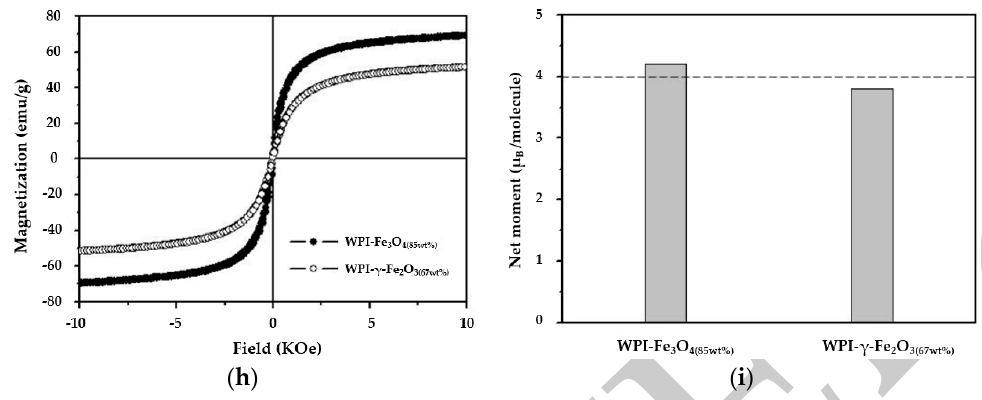
Figure 5. ( a ) Induction heating devices and ThermalGun that measure temperature; ( b ), ( c ) induction heating results of WPI- γ -Fe 2 O 3 and WPI-Fe 3 O 4 compared to the γ -Fe 2 O 3 and Fe 3 O 4 ; ( d ) heating results of WPI- γ -Fe 2 O 3(50wt%) ; ( e ) heating results of WPI- γ -Fe 2 O 3(67wt%) ; ( f ) heating results of WPI-Fe 3 O 4(50wt%) ; ( g ) heating results of WPI-Fe 3 O 4(85wt%) ; ( h ) hysteresis curve re- sult of WPI- γ -Fe 2 O 3(67wt%) and WPI-Fe 3 O 4(85wt%) ; ( i ) the net magnetic moment of WPI- γ -Fe 2 O 3(67wt%) and WPI-Fe 3 O 4(85wt%) .